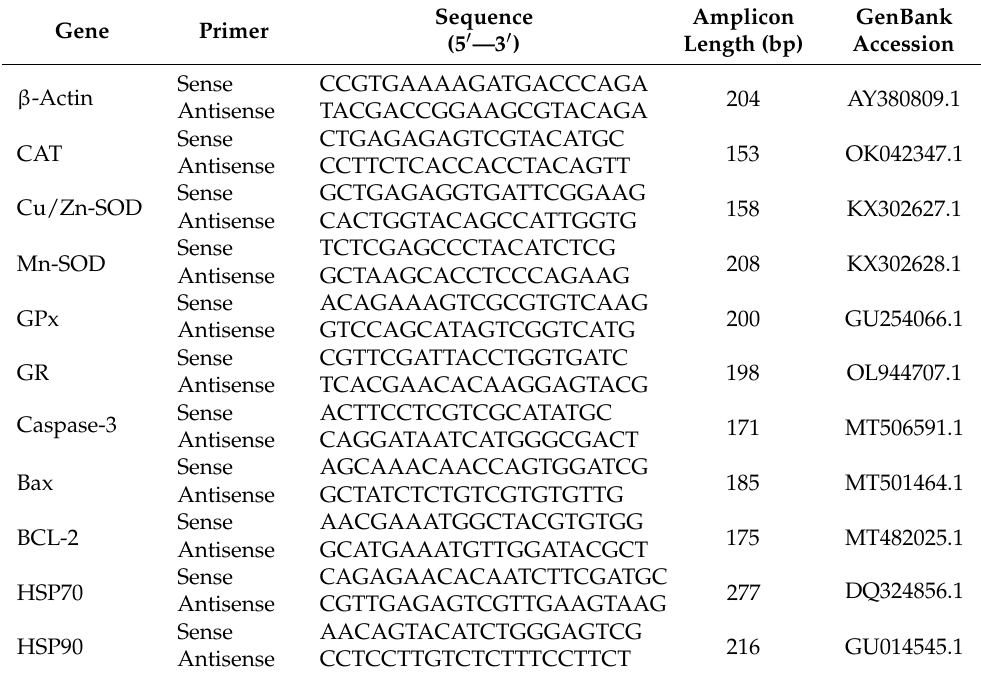
Table 1. List of primers used for qRT-PCR quantification of genes in sperm. Gene